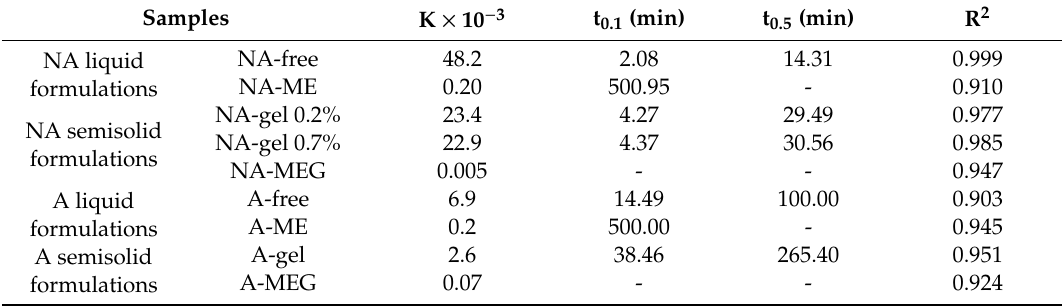
Table 2. Degradation kinetic parameters calculated for NA and A in di ff erent samples.